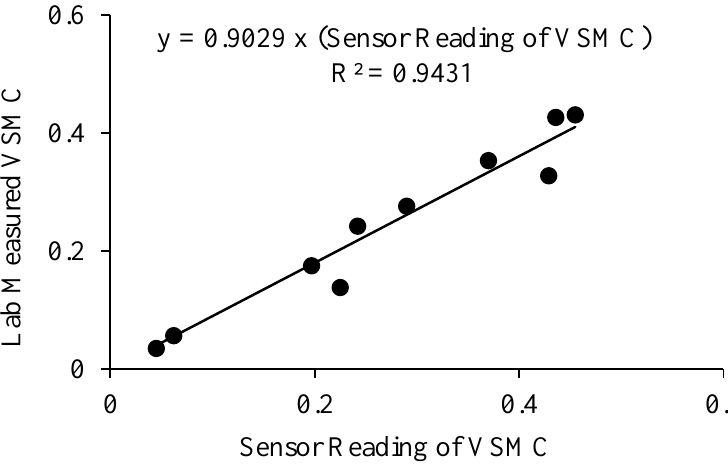
Figure 6. Validation of lab measured vs. sensor reading of VSMC [25].